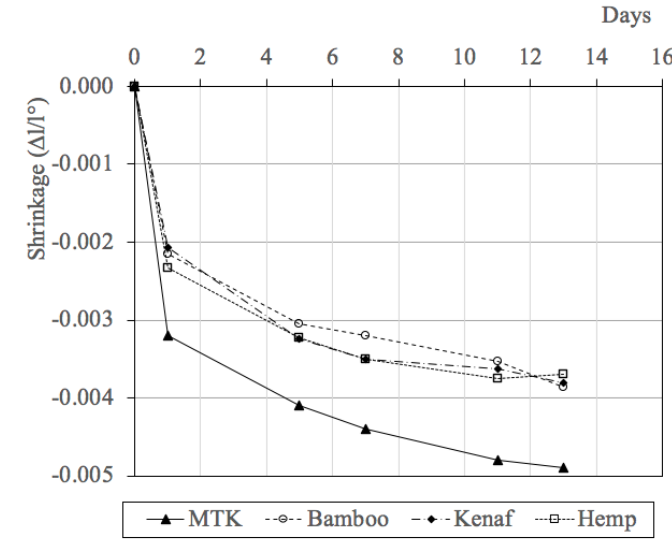
Figure 10. Dimensional variation vs. time for the 3 wt% fibers.